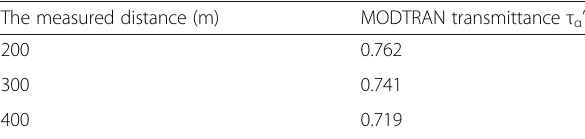
distances calculated by MODTRAN